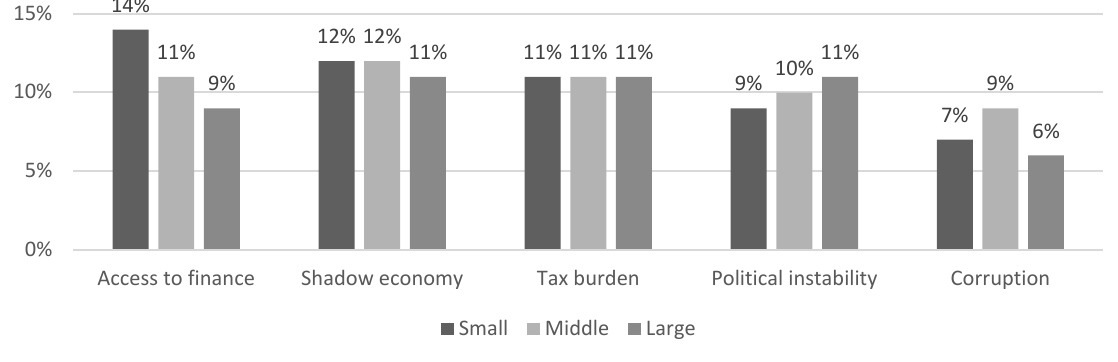
Figure 3. Main obstacles for SMEs growth in developing countries (Wang,